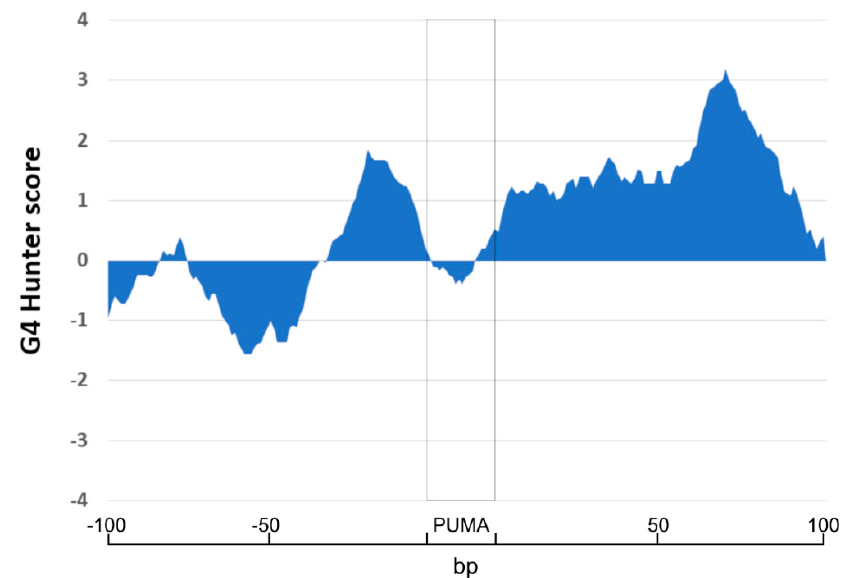
Figure 7. Localization of G4-prone sequences around p53 PUMA RE sequence (100 bp before and after p53 PUMA RE). The analysis of G4-prone sequences has shown that p53 PUMA RE (rectangle) in the human genome is surrounded by G4-prone sequences with peaks at 1.84 before p53 RE and long G4-prone sequence with the peak at 1.32 just after p53 RE and with a maximum peak with G4Hunter score 3.2). Even though the localization of both p53 RE and G4 sequences have been shown in the genome, the roles of G-quadruplexes in regulating transcription by p53 isoforms have not been evaluated.